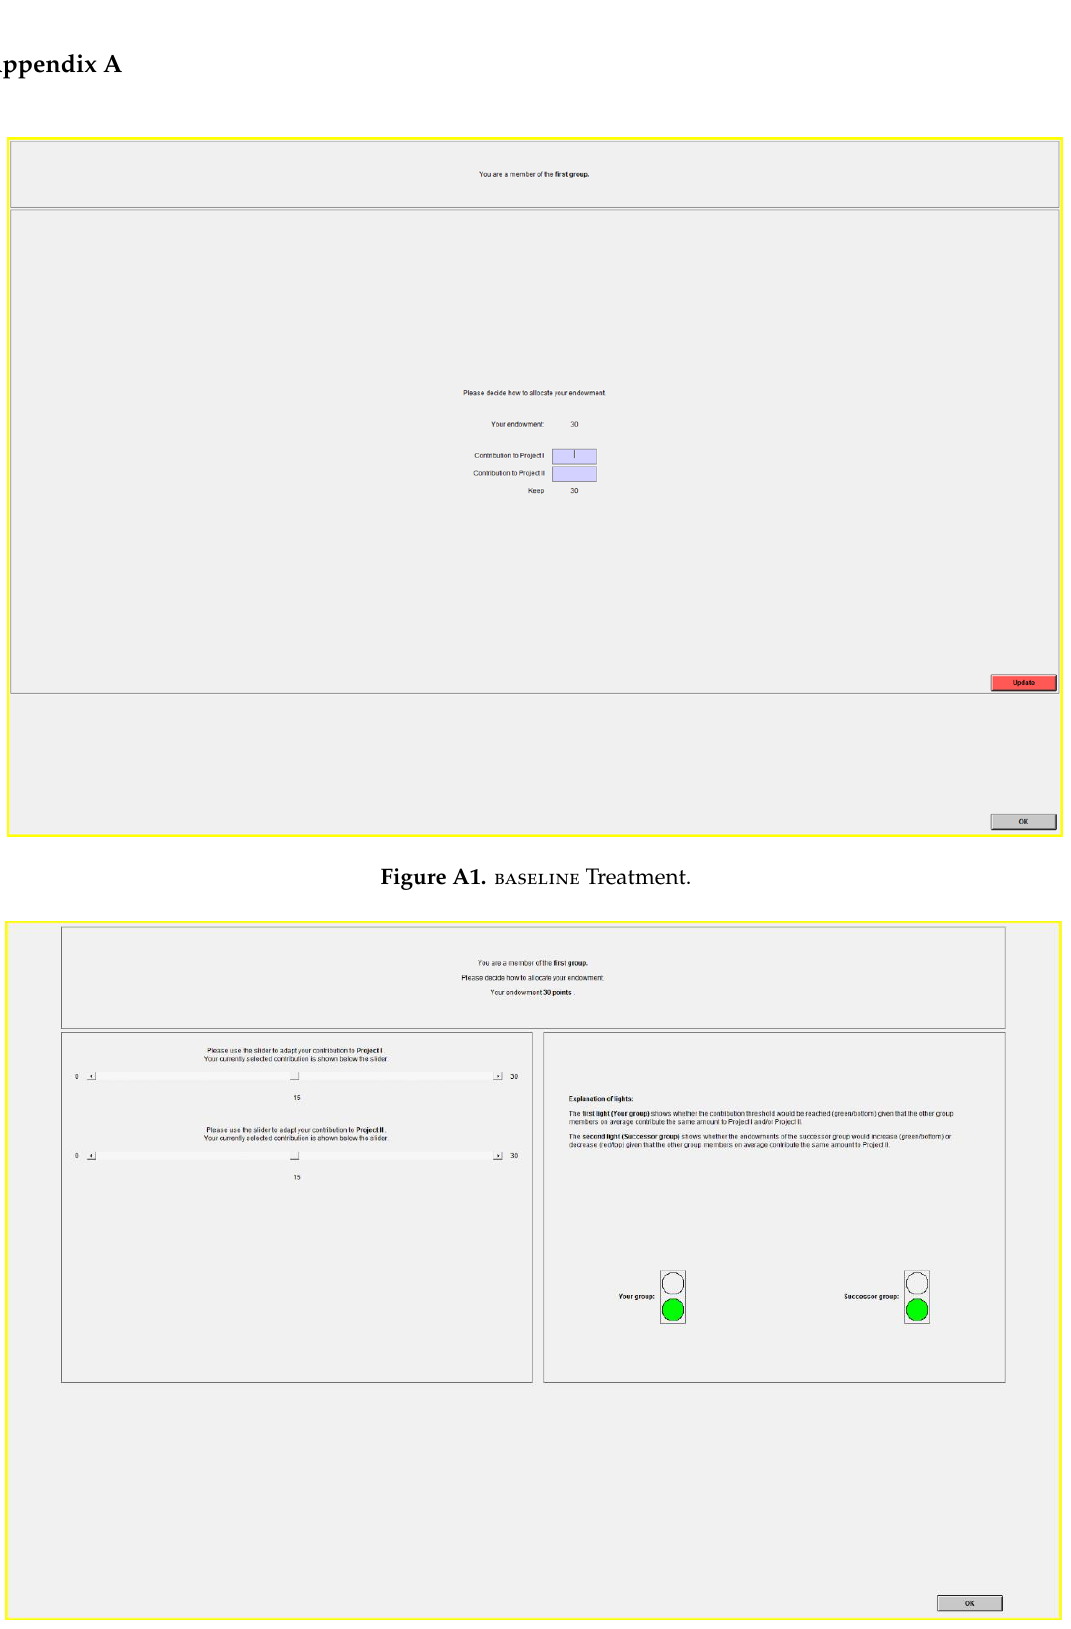
+ commitment Figure A2. default and default+commitment Treatment. Figure A2. Default and default Figure A2. default and default+commitment Treatment.